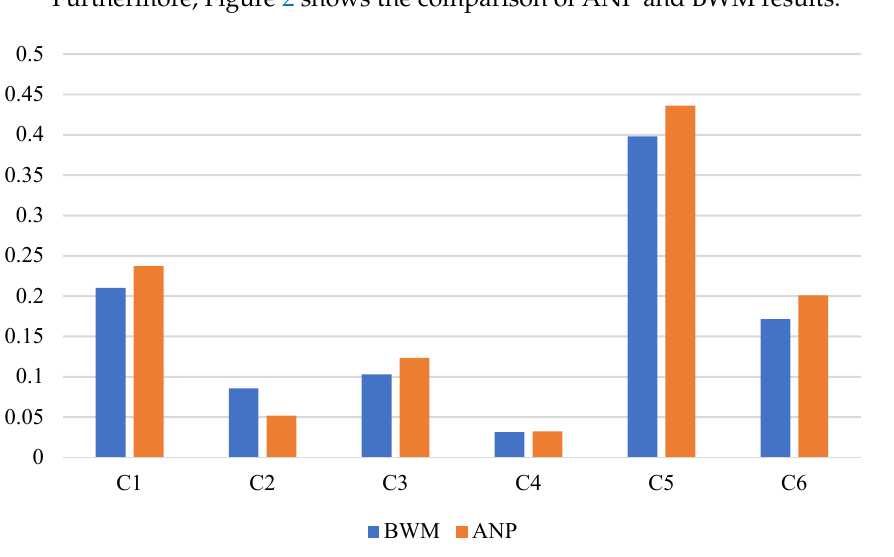
Table 13. Options prioritization using four MCDM methods. MV–CoCoSo